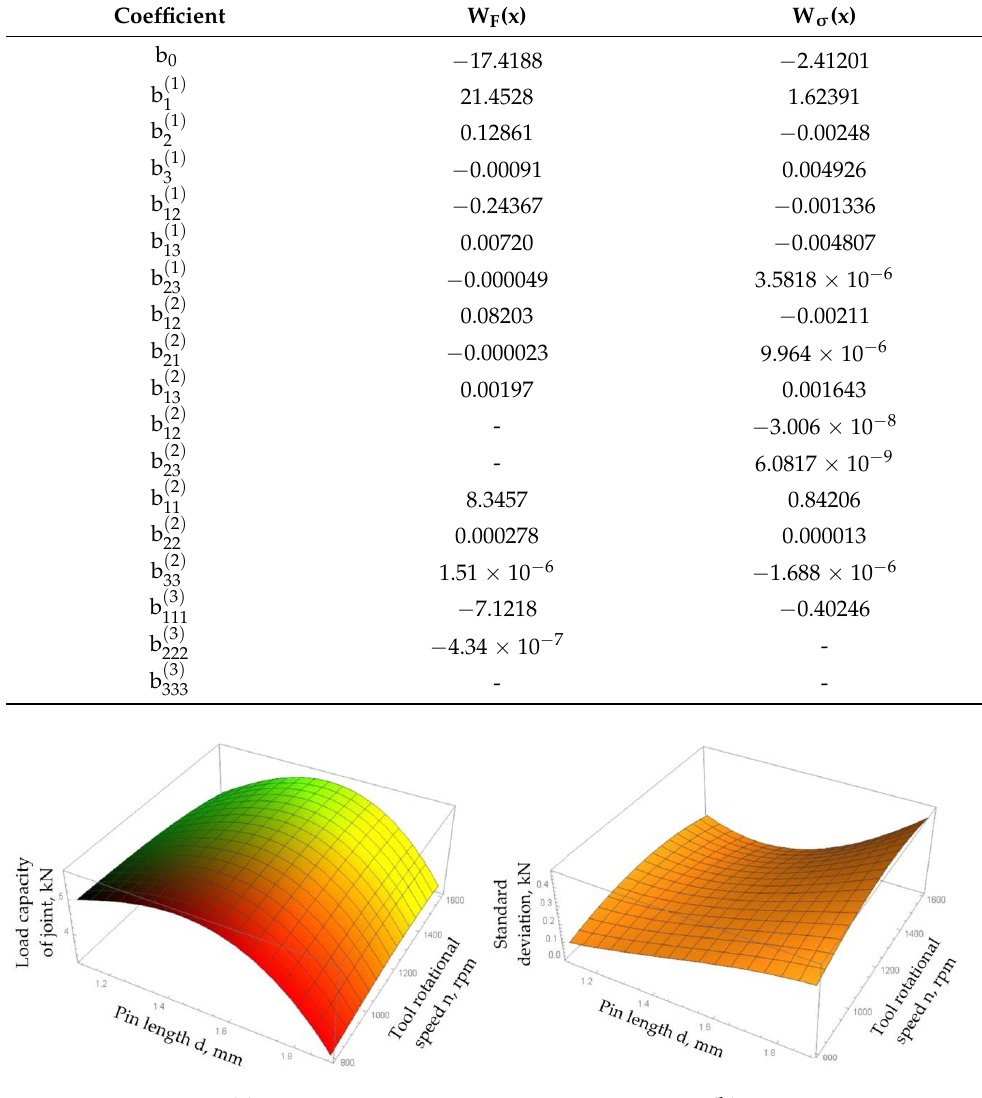
Table 5. Values of the coefficients of the regression equations W F (x) and W σ (x).